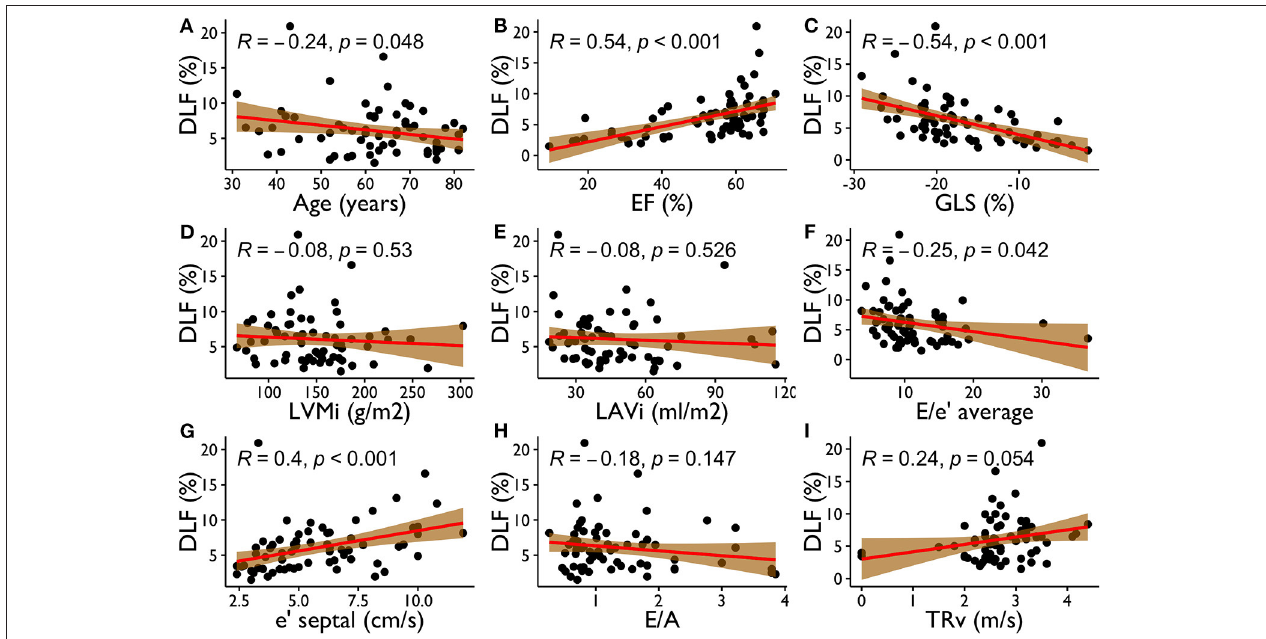
FIGURE 2 | Correlations between DLF and Age (A) , EF (B) , GLS (C) , LVMi (D) , LAVi (E) , E/e’ average (F) , e’ septal (G) , E/A (H) , TRv (I) . DLF, diastolic longitudinal force; EF, ejection fraction; GLS, global longitudinal strain; LVMi, left ventricular mass indexed to body surface area; LAVi, left atrial volume indexed to body surface area; e’ septal, septal tissue Doppler E wave; E/e’ average, E wave on transmitral Doppler/mean tissue Doppler E wave; E/A, E wave on transmitral Doppler/A wave on transmitral Doppler; TRv, tricuspidal regurgitation velocity.